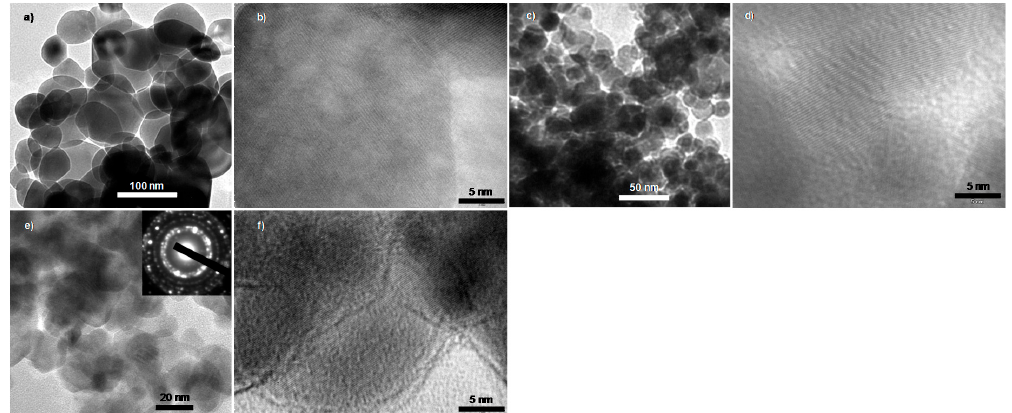
Figure 5. TEM images of organic composite-removed crystalline ( a , b ) ZnO -MeOH , ( c , d ) ZnO -EtOH and ( e , f ) ZnO - i PrOH . The inset in ( e ) is corresponding SAED pattern.